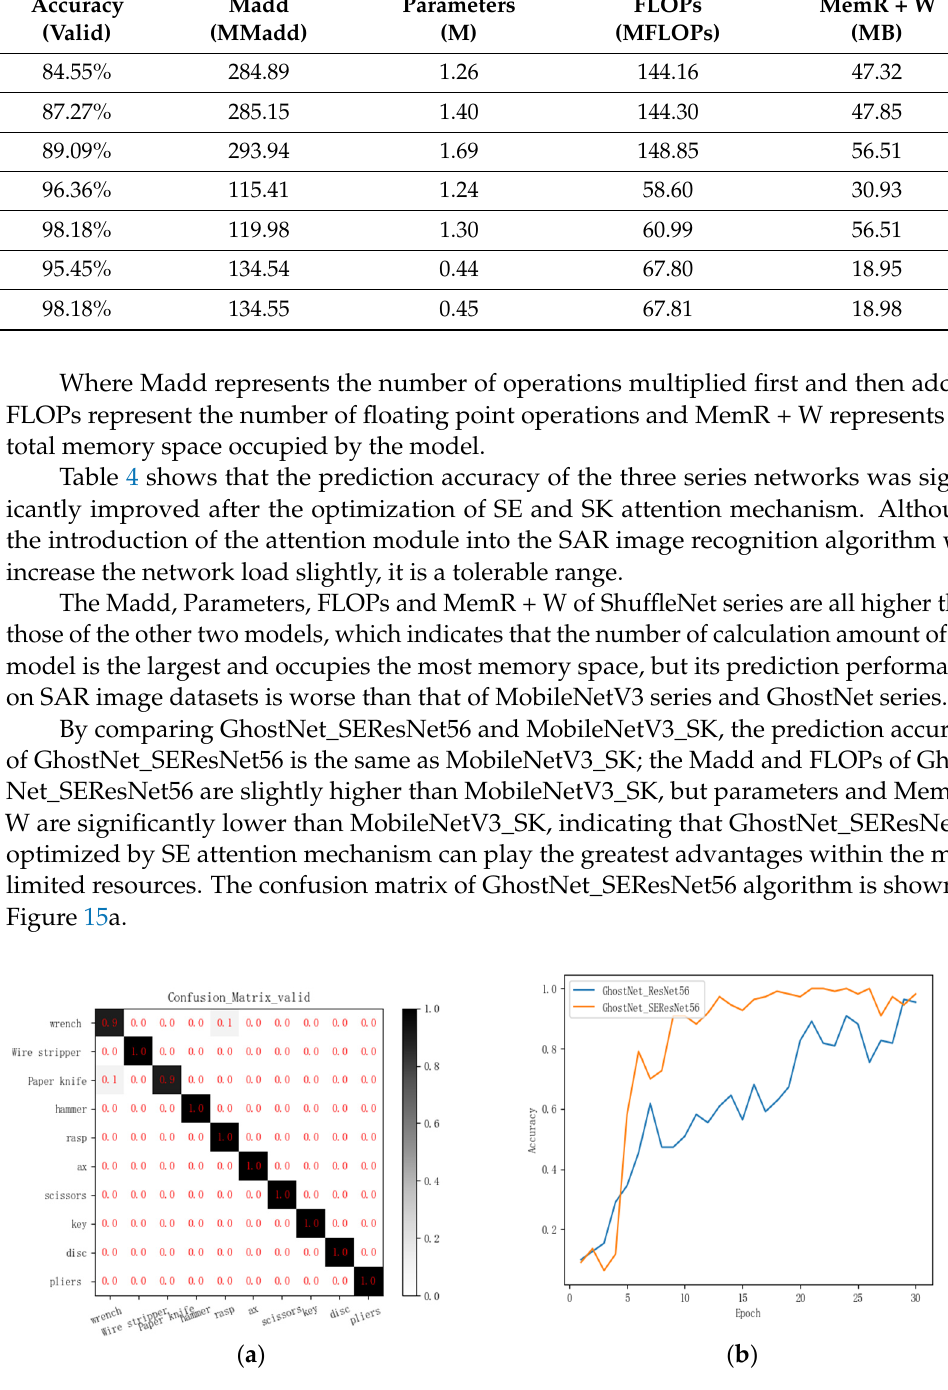
Figure 15. ( a ) GhostNet_SEResNet56 confusion matrix on the SAR validation set; ( b ) comparison of prediction accuracy of GhostNet_ResNet56 network and GhostNet_SEResNet56 network with Epoch changes.